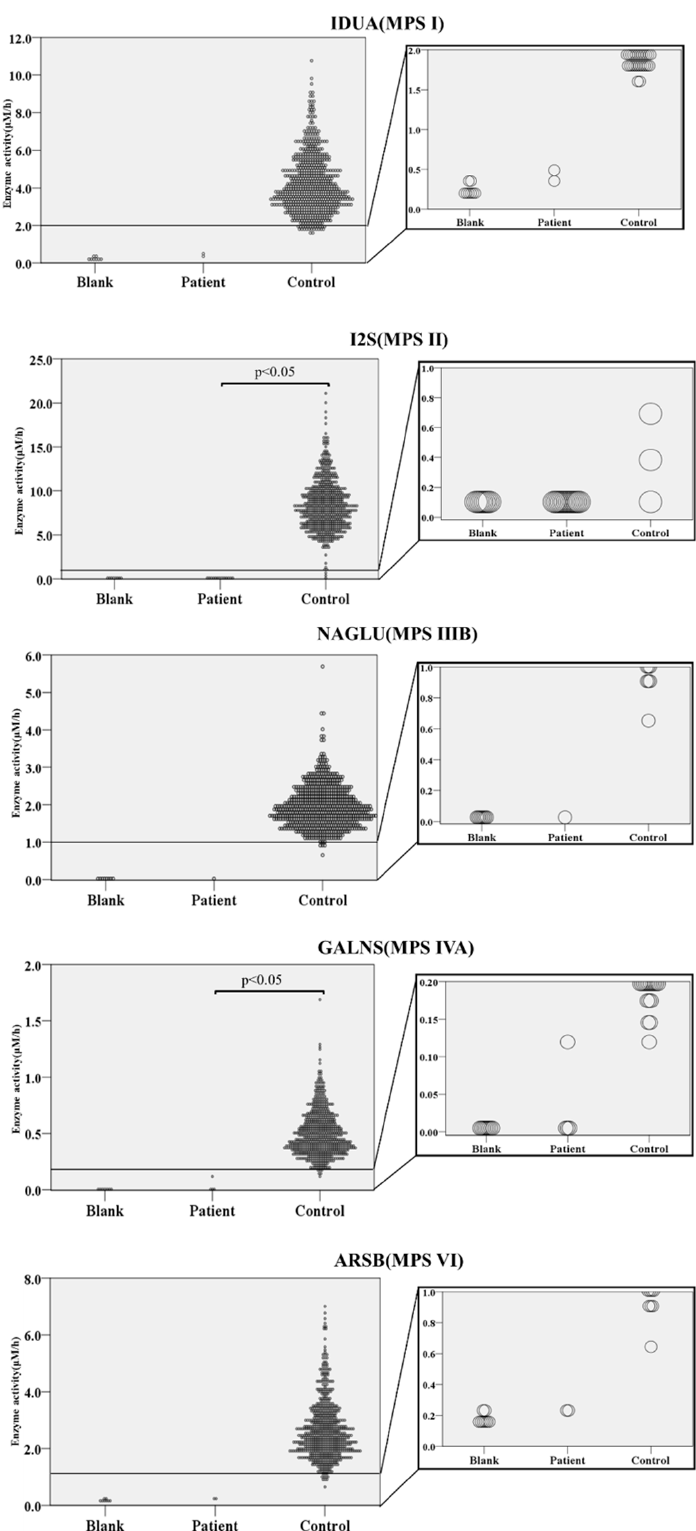
Figure 2. Violin plot of enzyme activities in dried blood spots (DBS). Blank; blank filter paper, patient(s); DBS from patient(s) with each type of MPS, controls; healthy subjects. Enlarged view of low-enzyme-activity area is shown by small window. Values of enzyme activities in blank ( n = 5), in controls ( n = 672), and patients with MPS: MPS I ( n = 2), MPS II ( n = 14), MPS IIIB ( n = 1), MPS IVA ( n = 4), and MPS VI ( n = 2) were plotted. Mean enzyme activities of control samples were 4.19 µM/h in MPS I, 8.91 µM/h in MPS II, 1.96 µM/h in MPS IIIB, 0.50 µM/h in MPS IVA, 2.64 µM/h in MPS VI. In the histograms for all types of MPS enzymes, the shapes of the histograms indicated a highly skewed distribution. However, in the histogram for MPS II, there were some control samples that